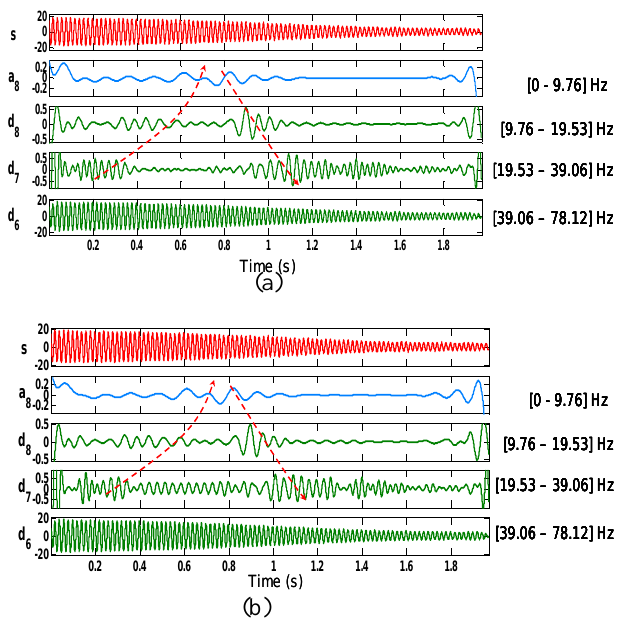
Fig. 14. 8-level DWT of the startup current for the unloaded machine with one broken bar using: (a) symlet-30, (b)